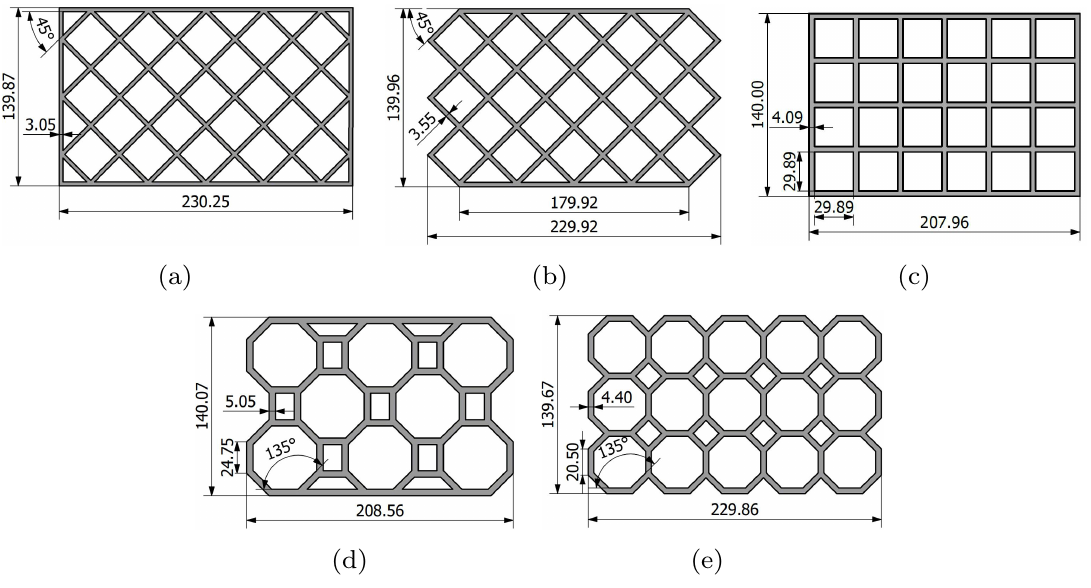
Figure 4. Dissipating plates for SPSYD ( a ) P1, ( b ) P2, ( c ) P3, ( d ) P4 and ( e ) P5 (dimensions in mm).